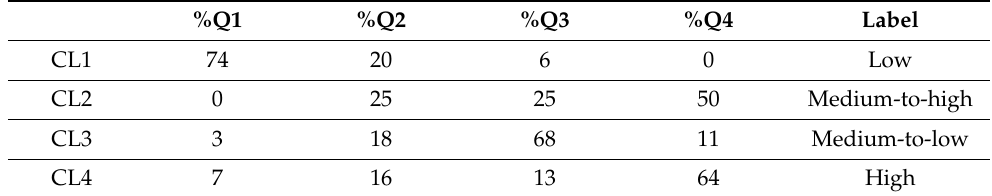
Table 2. Quartile distribution of the a g , max variable in the four clusters.